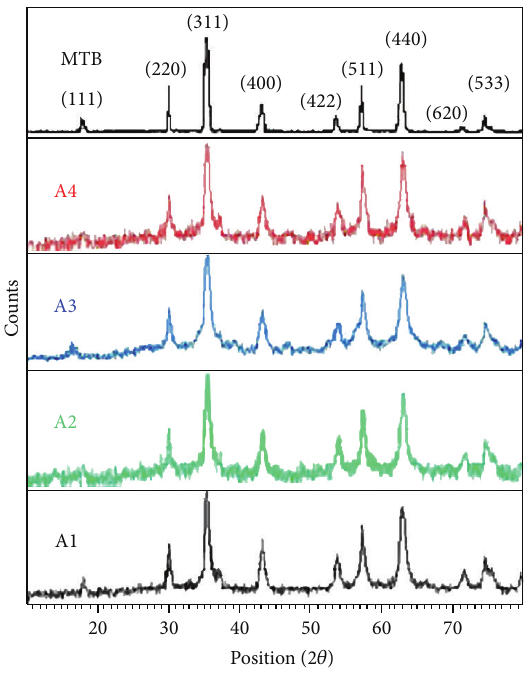
Figure2:X-raypowderdiffractionpatternofmagnetitesamples(A1 to A4) prepared at different temperatures compared to XRD pattern of magnetite in MTB was reported [9].